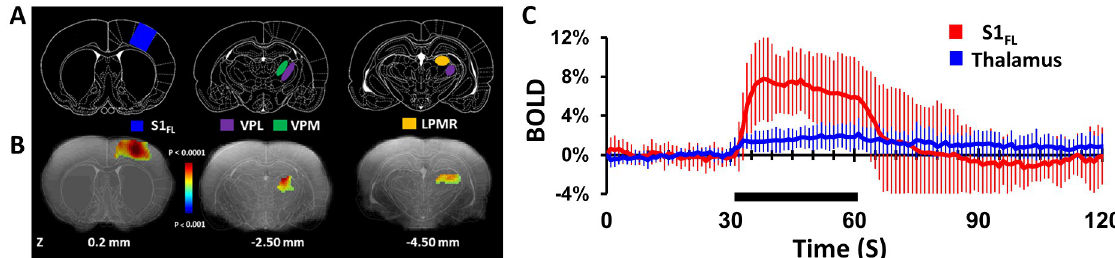
Fig 1. Forepaw stimulation-induced activation of rat somatosensory cortex and thalamus revealed by high-field (11.7T) fMRI (8 rats, 28 trials). Significant BOLD activations were observed at the contralateral primary somatosensory cortex area of forelimb (S1 FL ) and thalamic activations were found in different parts of ventral posterior lateral (VPL), ventral posterior medial (VPM), lateral posterior thalamic nucleus mediorostral (LPMR) during left forepaw stimulation (2 mA, 0.3 ms, 3 Hz). BOLD activation maps, displayed as colored statistical maps (a 2-sample, unpaired, T-test with equal variance and one tail for stimulation (30s) > baseline (30s)) overlaid on the corresponding anatomical images. A and B represents coronal slices corresponding to cortical and thalamic regions positioned at 0.2 mm anterior to bregma for S1 FL , 2.50 and 4.50 mm posterior to bregma for VPL, VPM and LPMR regions. To correlate activations in cortical and thalamic regions, reference stereotaxic atlas images were overlaid on the corresponding anatomical images. C represents the mean ± SD time course of BOLD activations at S1 FL and thalamic (VPL, VPM and LPMR)